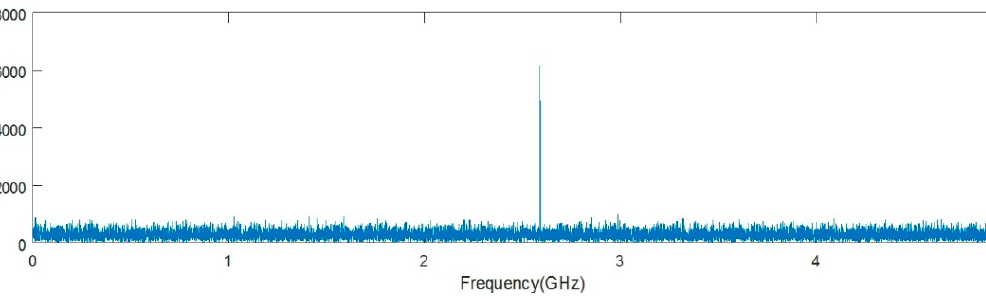
Figure 8. Single hop spectrum.